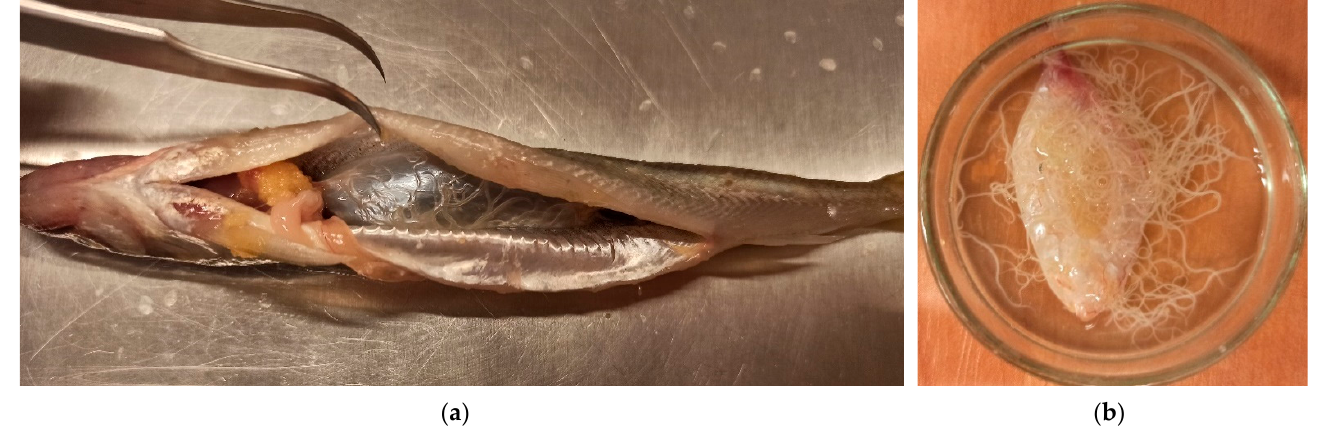
Figure 1. Cystidicola farionis parasitizing the swim bladder of European smelt Osmerus eperlanus ; ( a ) Smelt dissection with swim bladder exposed; ( b ) Swim bladder with nematodes.